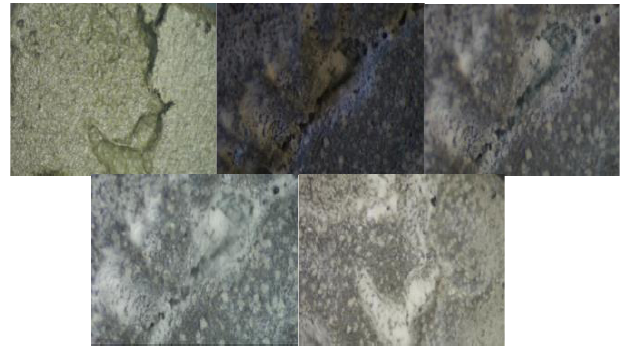
Figure 7. Images of a mortar crack with MSS (6%) at the age of 79 days.